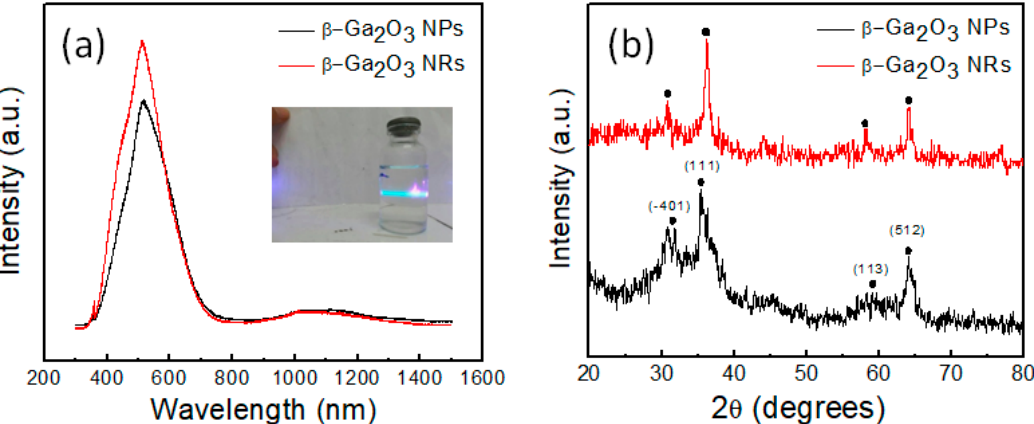
Figure 2. ( a ) HRXRD di ff raction spectra of as-synthesized β -Ga 2 O 3 and GaOOH. ( b ) Raman spectra of β -Ga 2 O 3 NRs.